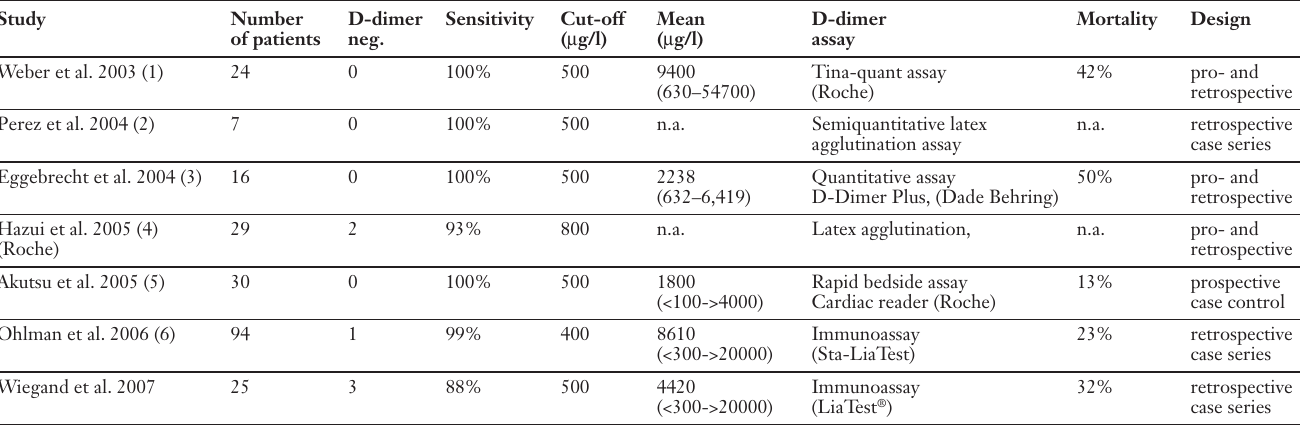
D-dimer Sensitivity